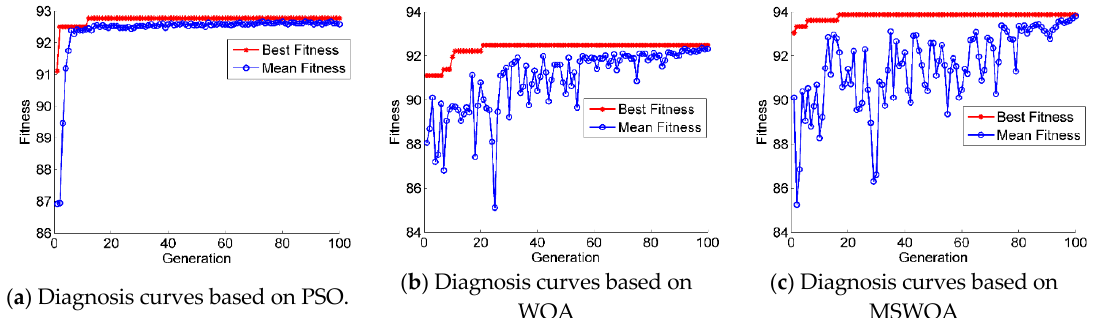
Figure 18. Fault diagnosis accuracy curves of the three methods optimized support vector machine (SVM).